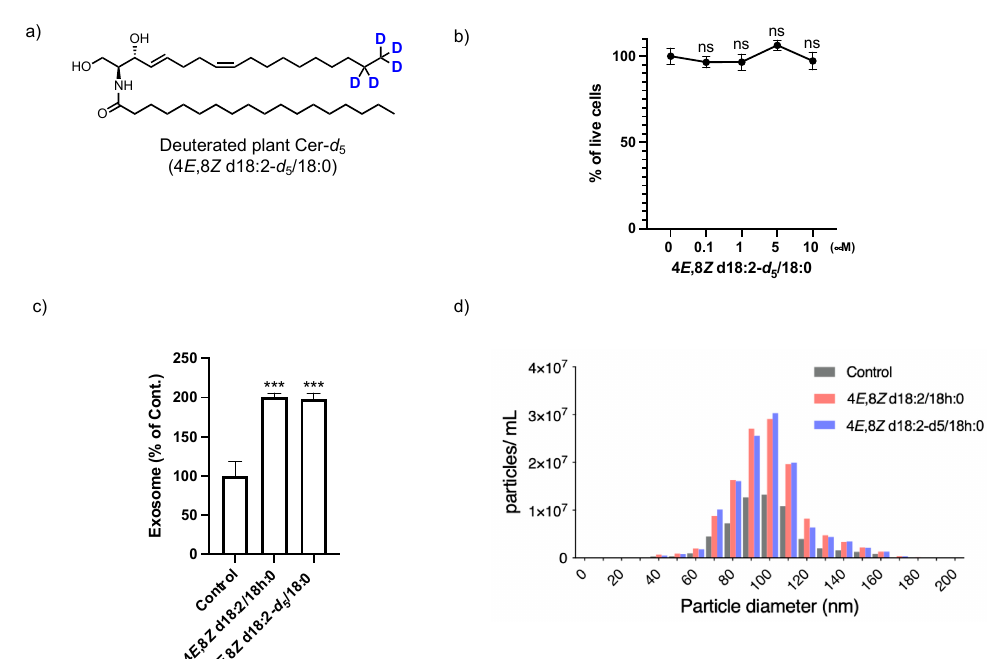
Figure 6. ( a ) Structure of 4 E ,8 Z d18:2- d 5 /18:0. ( b ) CCK-8 viability assay of SH-SY5Y cells exposed to 4 E ,8 Z d18:2- d 5 /18:0. Results were normalized against controls and represented as the mean ± SD ( n = 3). ( c ) Quantification of exosomes released from SH-SY5Y cells treated without (Control) or with 4 E ,8 Z d18:2- d 5 /18:0 for 24 h. Exosomes were quantified using a PS-Capture Exosome ELISA system. Results were normalized against controls and represented as the mean ± SD ( n = 3; *** p < 0.0001 vs. Control). ( d ) Particle size distributions of exosomes derived from control, and deuterium-labeled or unlabeled Cer-treated cells.